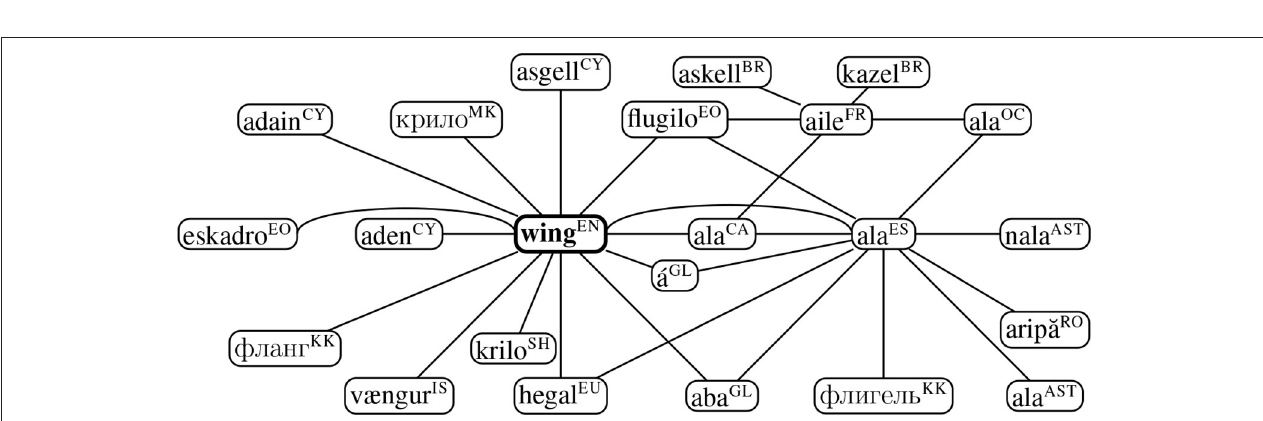
FIGURE 7 | Paths starting from wing (noun) in the Apertium translation data (Goel et al., 2021) where a non-exhaustive list of translations can be retrieved by traversing individual paths. ISO 639-1 language codes are provided in superscript.